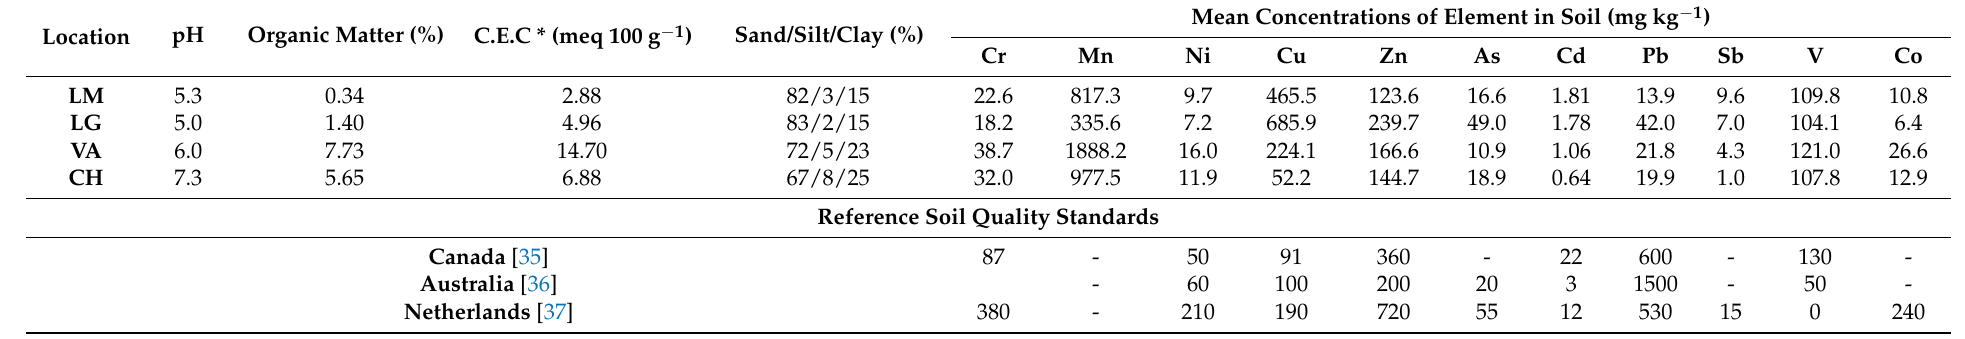
Table 3. Physicochemical characteristics and trace element levels of the composite soil samples collected at the sampling locations Los Maitenes (LM), La Greda (LG), Valle Alegre (VA), the and reference sampling point at Cachagua (CH). Reference soil quality standards guidelines are also